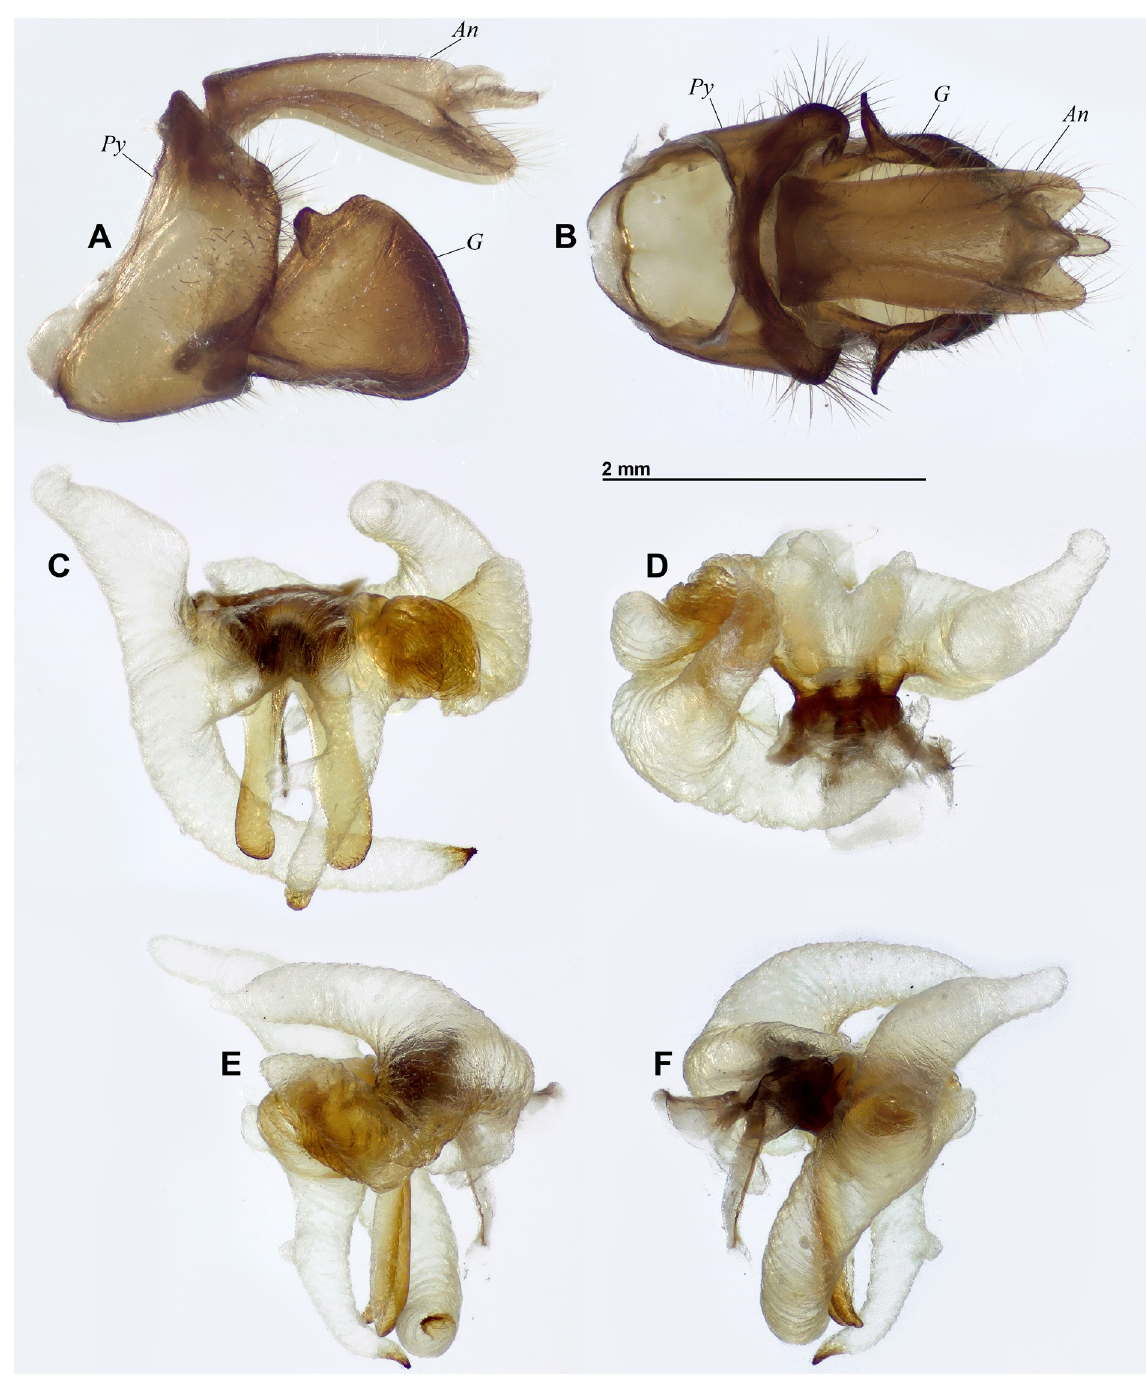
Fig. 2. Birdantis bhaskarai sp. nov., holotype, ♂, genitalia. A . Pygofer, anal tube and gonostyli, left lateral view. B . Pygofer, anal tube and gonostyli, dorsal view. C . Aedeagus, posterior view. D . Aedeagus, dorsal view. E . Aedeagus, right lateral view. F . Aedeagus, left lateral view. Abbreviations: An = anal tube; G = gonostyli; Py =